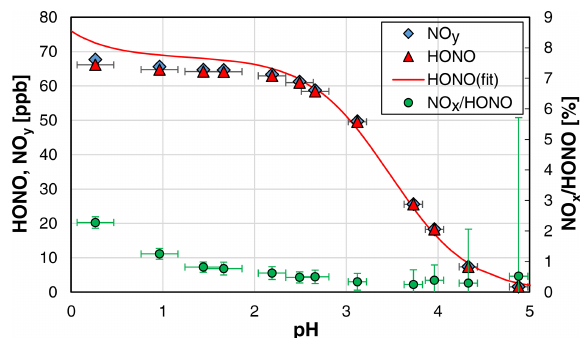
Figure 2. Dependence of the HONO mixing ratio and the NO x / HONO ratio on the pH of the NO − –H 2 SO 4 reaction mix- 2 ∅ , dry = 1mgL − 1 ; T = 15.9 ◦ C, φ = 1570cm 3 min − 1 , ture (NO − g 2 20rpm). In addition, the theoretical HONO mixing ratios calculated by Eq. (3) (see Sect. 4.2) are also shown, for which p K a = 3.16 was used (weighted average of all shown data at pH > 2.4). The y error bars represent the precision errors (2 σ ), which are only visible for the NO x / HONO ratio but smaller than the size of the symbols for HONO and NO y . The x error bars represent the accuracy of the pH